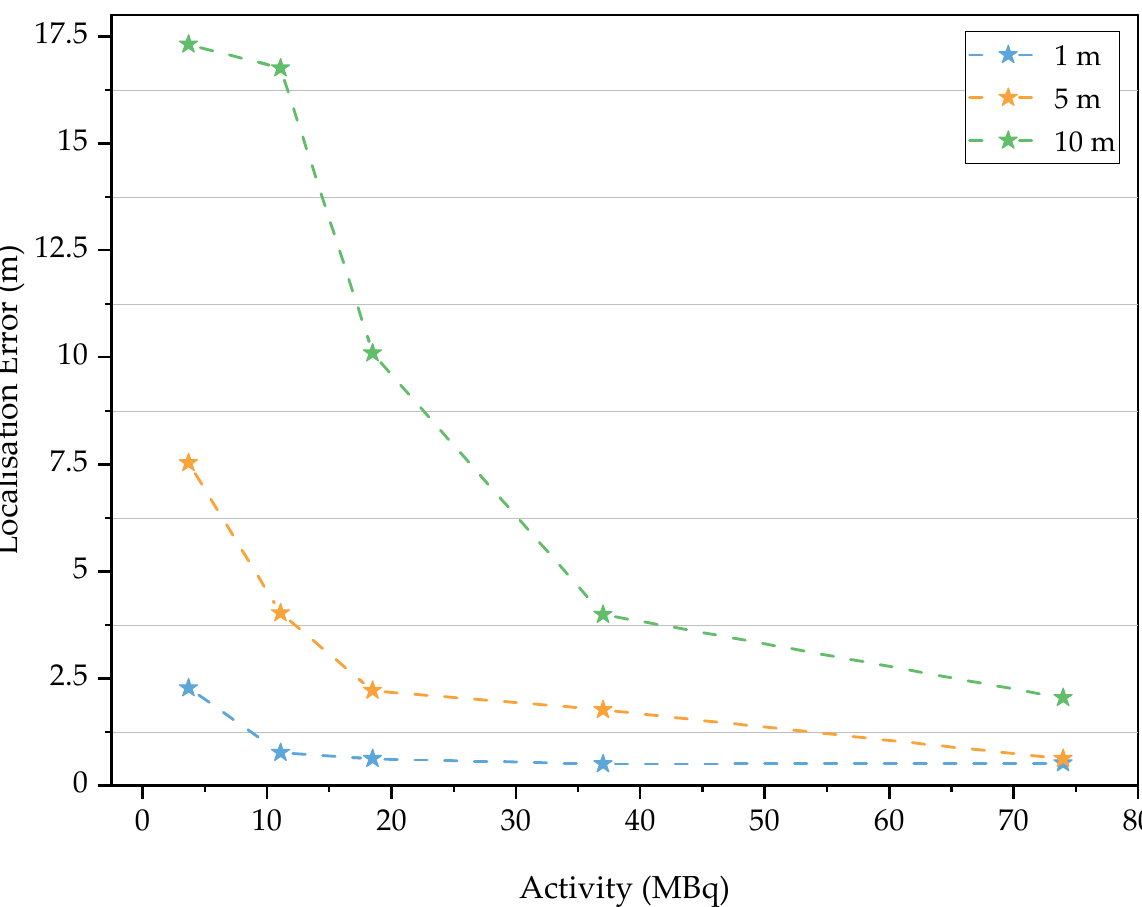
Figure 10. Source localisation errors for various activity source profiles injected into background measurements taken in a 450 × 350 m urban area. Injected source profiles correspond to a 137 Cs source at distances of 1, 5 or 10 m from the background measurement positions. Results from